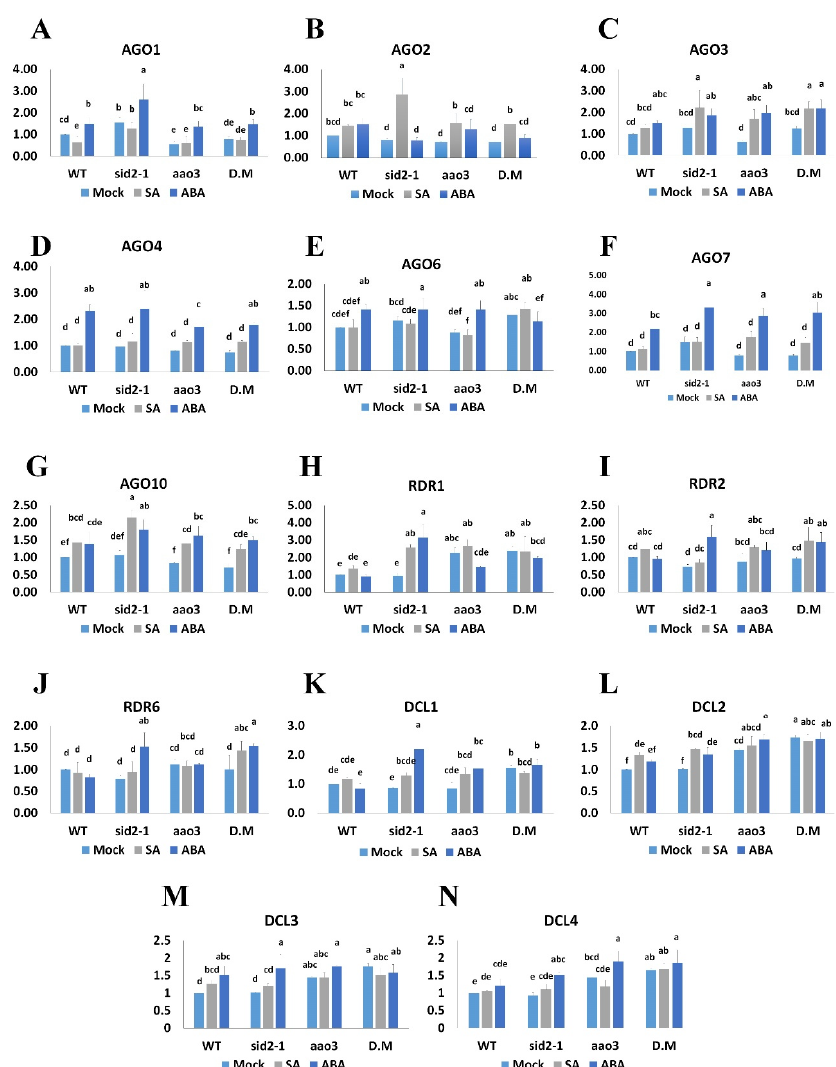
Figure 2. E ff ects of ABA and SA treatment on the relative expression (as determined by RT-qPCR) of ( A ) AGO1 , ( B ) AGO2 , ( C ) AGO3 , ( D ) AGO4 , ( E ) AGO6 , ( F ) AGO7 , ( G ) AGO10 , ( H ) RDR1 , ( I ) RDR2 , ( J ) RDR6 , ( K ) DCL1 , ( L ) DCL2 , ( M ) DCL3 , and ( N ) DCL4 in seedlings of the Arabidopsis thaliana wild type (WT), the SA mutant sid2-1 , the ABA mutant aao3 , and their double mutant (D.M) sid2-1:aao3 . Six-day-old seedlings were treated with SA (50 µM), ABA (10 µM), or mock (0.1% EtOH); expression was determined by RT-qPCR 2 days later. Values are means + SD of three biological replicates, each carried out with three technical replicates. Analyses of variance (ANOVAs) were conducted to determine significant differences ( p < 0.05); when ANOVAs were significant, the means for each gene were compared with a Duncan’s post hoc test; means that share a lowercase letter are not statistically different, while different letters denote for statistical differences at least 95% confidence.